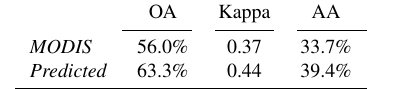
Table 5. Accuracy metrics of the LCCS maps for the Rome scene. The predicted result was achieved by semantic segmentation based on a DenseNet CNN. The evaluation is based on manually labeled reference